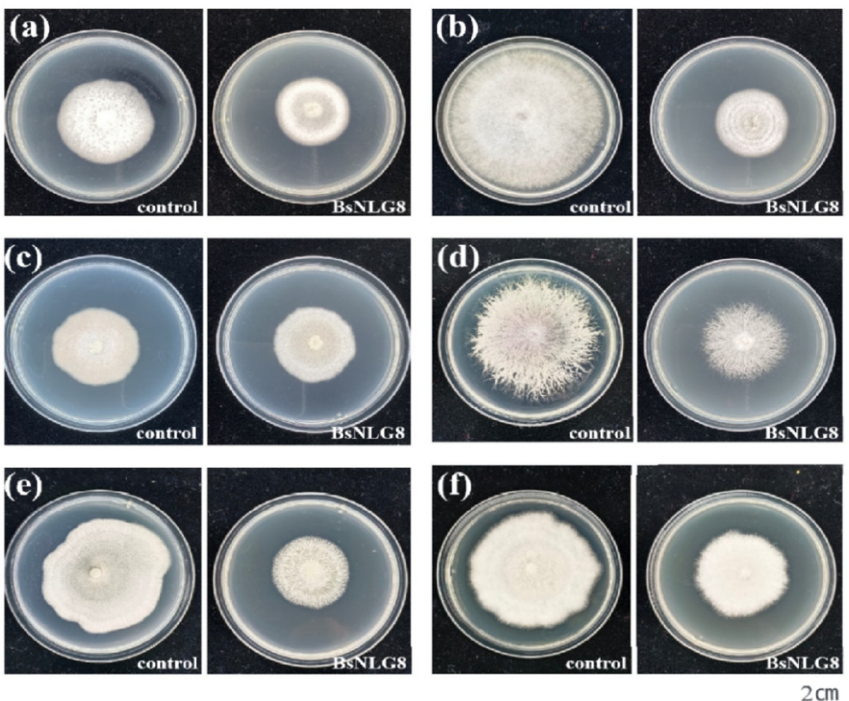
Figure 3. Aseptic filtrate of BsNLG8 and culture map of pathogenic fungi. Effects of volatile compounds from bacterial BsNLG8 on the growth of fungal colonies. ( a ) M. oryzae , ( b ) F. oxysporum , ( c ) G. candidum , ( d ) S. curtisii , ( e ) C. higginsianum, and ( f ) B. dothidea.